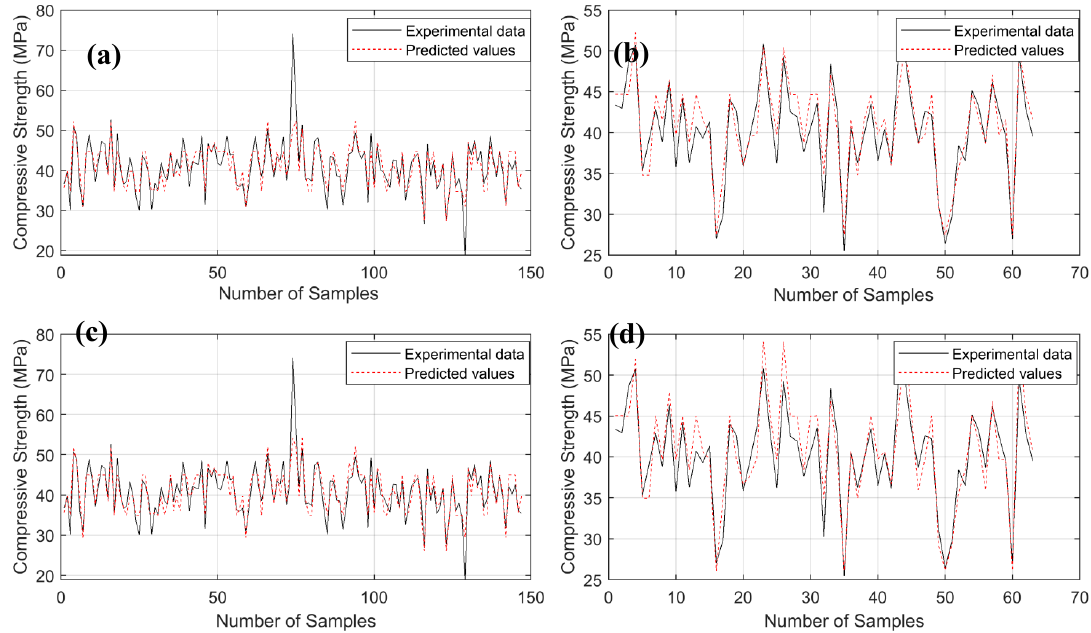
Figure 6. Experimental and predicted values of compressive strength with different models: ( a ) training particle swarm optimization (PSO)-based ANFIS (PSOANFIS), ( b ) testing PSOANFIS, ( c ) training genetic algorithm (GA)-based ANFIS (GAANFIS), and ( d ) testing GAANFIS. Appl. Sci. 2019 , 9 , x